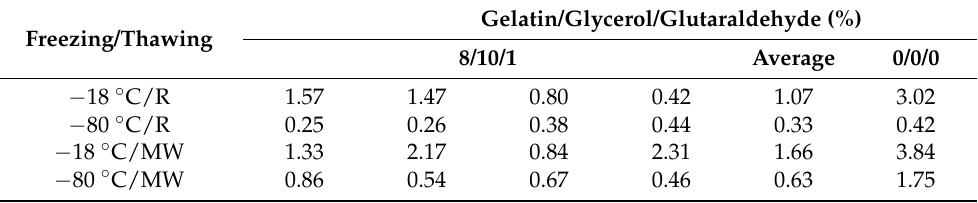
Table 10. Weight loss of meat (%) after thawing with and without crosslinked coating depending on the method of freezing and